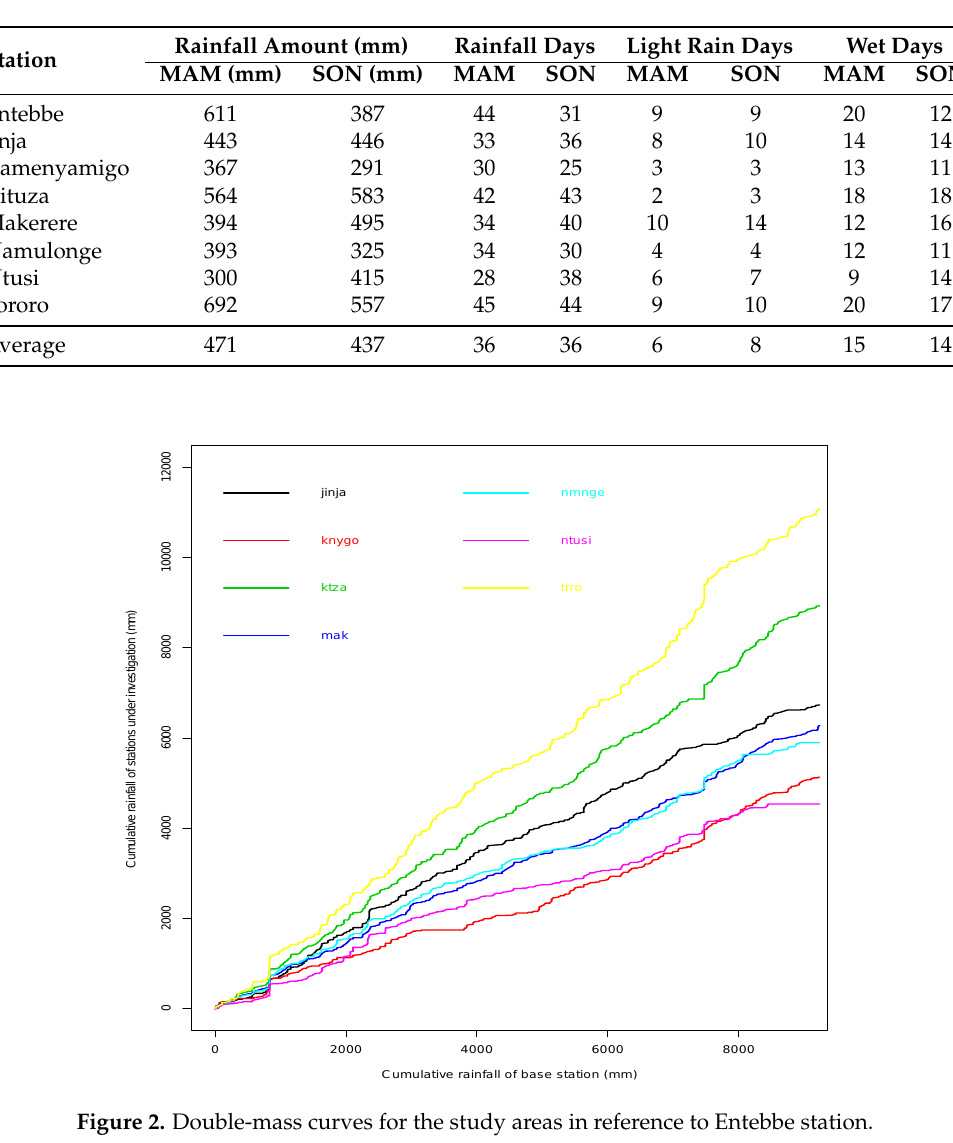
Table 1. Average MAM and SON seasonal rainfall characteristics.